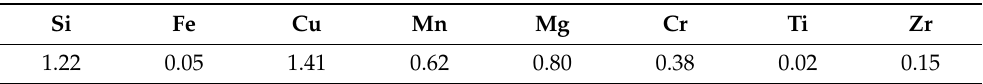
Table 1. The chemical composition of investigated alloy, mass percentage. Si Fe Cu Mn Mg Cr Ti